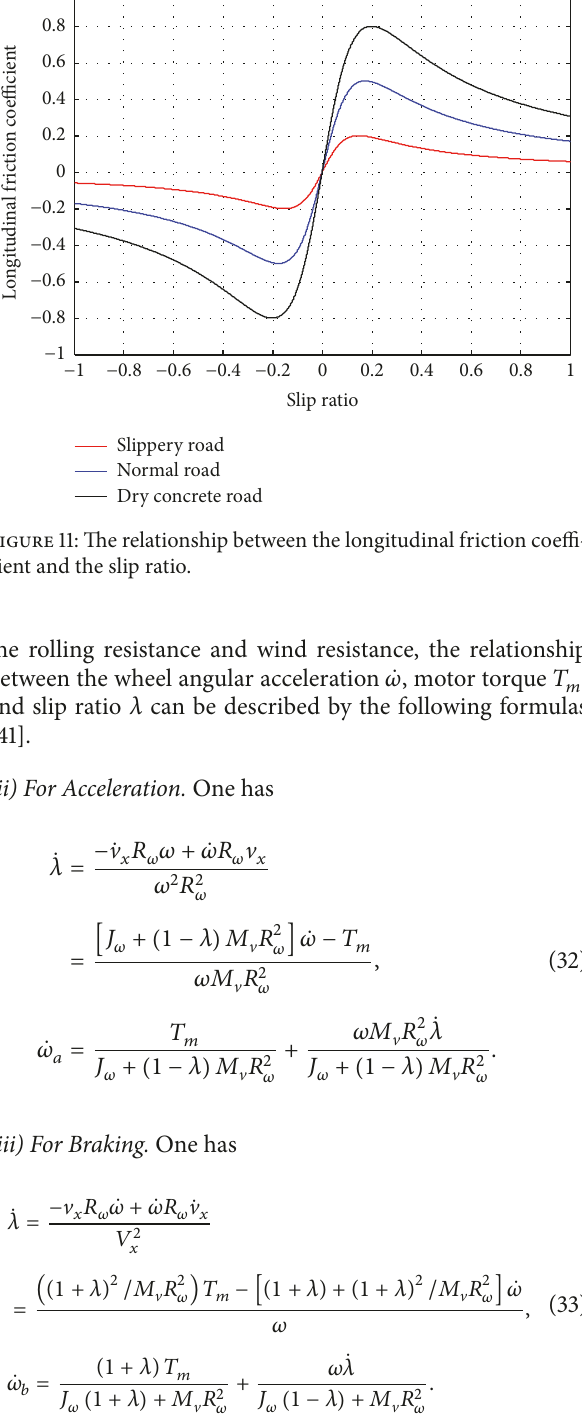
Table 1: Fuzzy logic